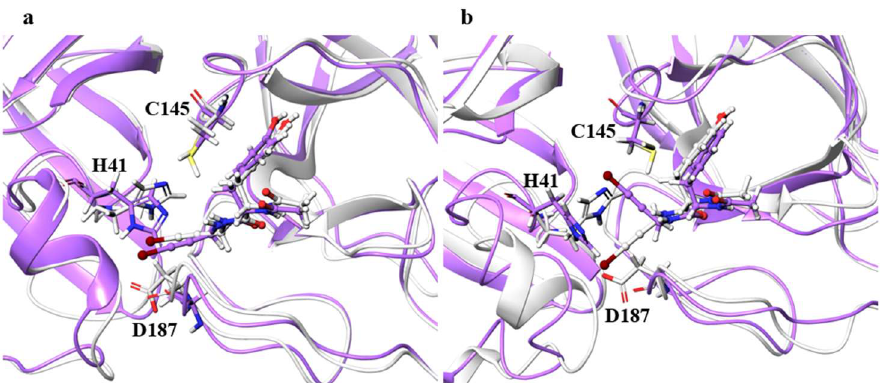
Figure 5. Structures around the ligand in the ( a ) A and ( b ) B chains. Atoms and chains of wild type and D187A are presented in white and purple, respectively. The ligand is represented by the ball-and-stick model, while H41, C145, and D187 are represented by the stick model.